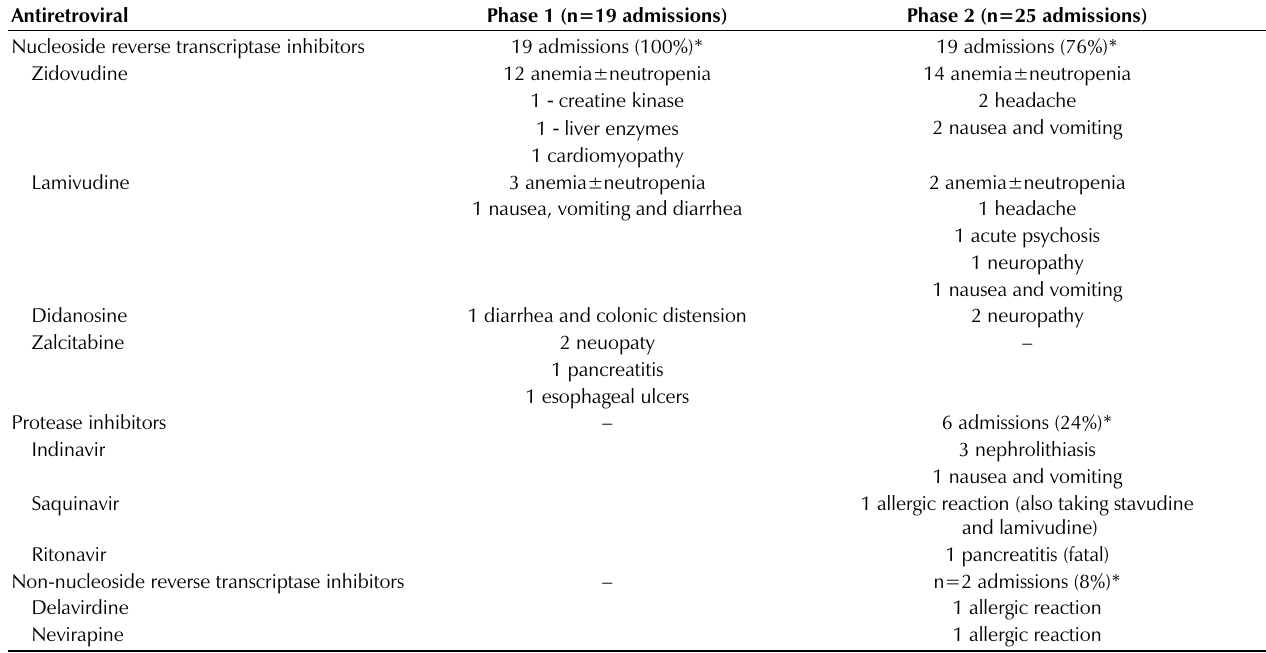
Antiretrovirals associated with adverse drug events on admission of patients before and after the introduction of highly active antiretroviral therapy (HAART)